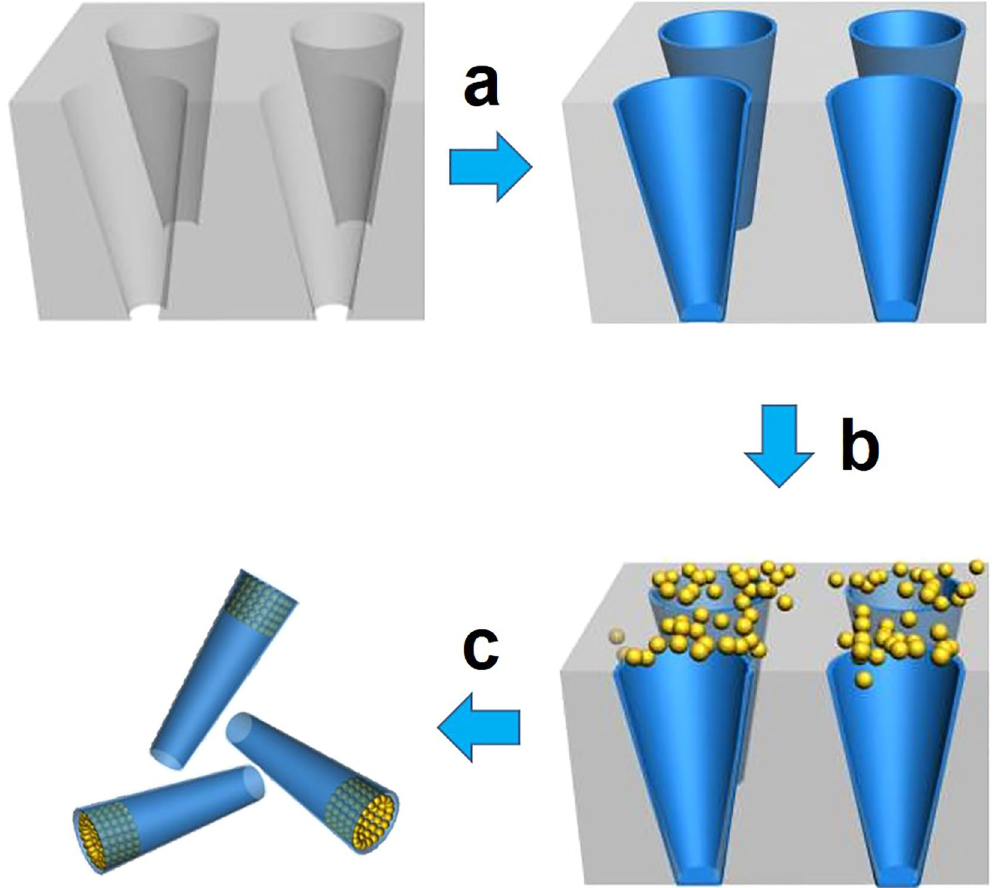
Figure 1. Fabrication Process of the Gold Film-functionalized Torpedo Motor. ( a ) Deposition of 3 layers of silica via the sol-gel method. ( b ) Deposition of Au nanoparticles to the big opening of torpedo motor. ( c ) Dissolution of the porous template to obtain the resulting